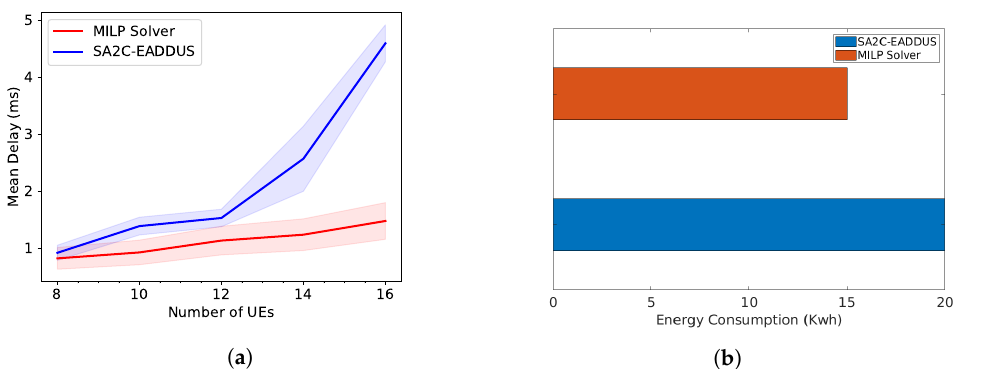
Figure 5. Lower bound comparisons of the proposed method SA2C-EADDUS: ( a ) mean delay com- parison; ( b ) energy consumption